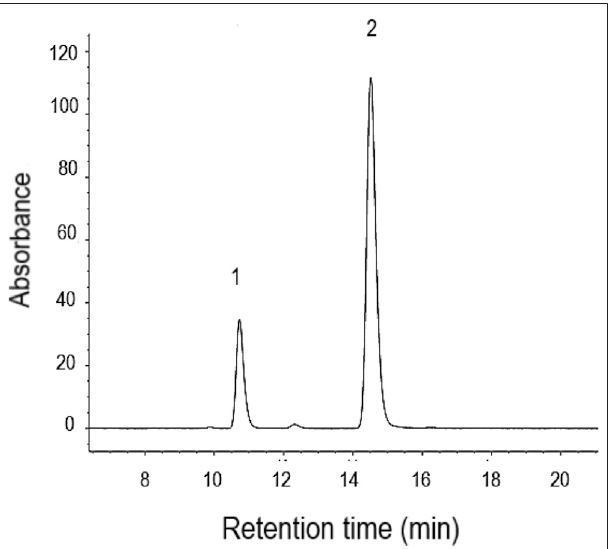
FIGURE 2 | The separation of caffeine (1) and benzotriazole (2), the internal standard, in saliva extract using isocratic method by HPLC with UV. The retention time for caffeine and benzotriazole is 10.7 and 14.5 min,